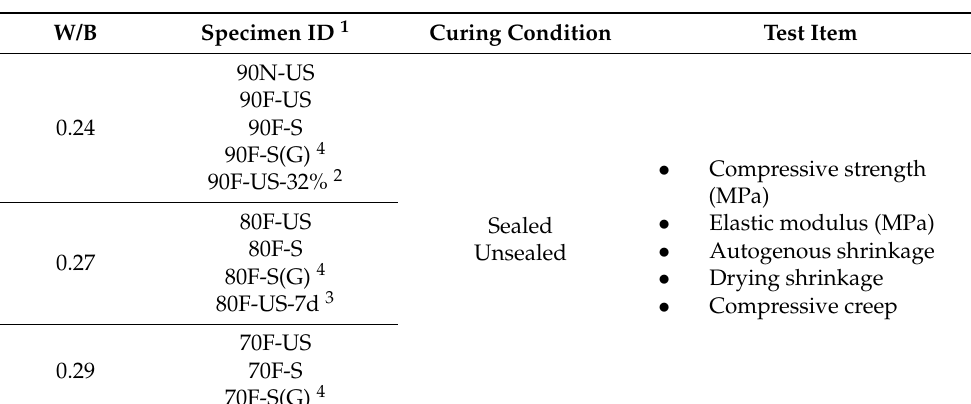
Table 1. Experimental plan.